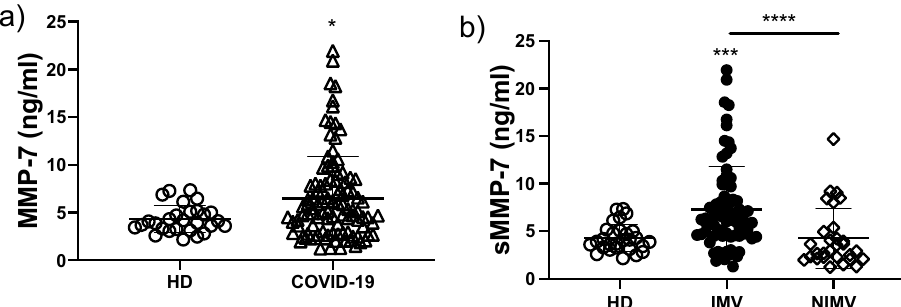
Figure 3. The circulating level of sMMP-7 is increased in COVID-19 patients that required IMV. Serum levels of MMP-7 (sMMP-7) were evaluated in total COVID-19 patients and divided into invasive mechanic ventilation (IMV) and non-invasive mechanic ventilation (NIMV) groups ( a , b ). Graphs show individual values and the mean ± SD. Statistical analysis was performed with the Mann–Whitney test ( a ) or an ANOVA test adjusted by the Kruskal–Wallis method ( b ). * p < 0.05, *** p < 0.001, **** p < 0.0001. Asterisks indicate a significant comparison with the healthy donor (HD) group, and when the asterisk is over a line, it indicates a significant comparison between IMV and NIMV. Empty circles represent healthy donors group, empty triangles COVID-19 group, black circles NIMV group, empty diamonds IMV group.